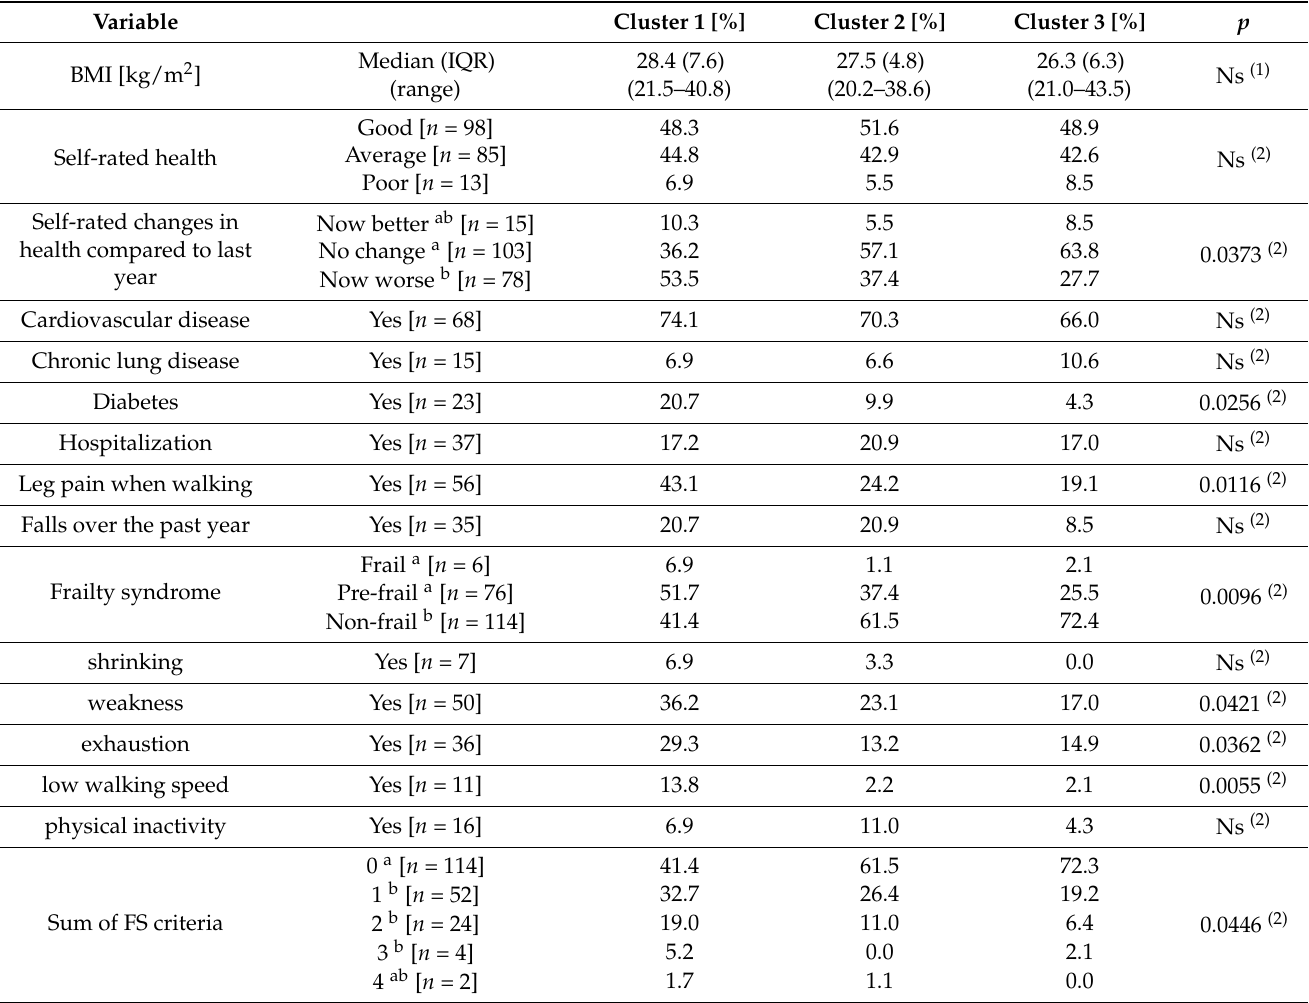
Table 2. Health variables of the study population by clusters.